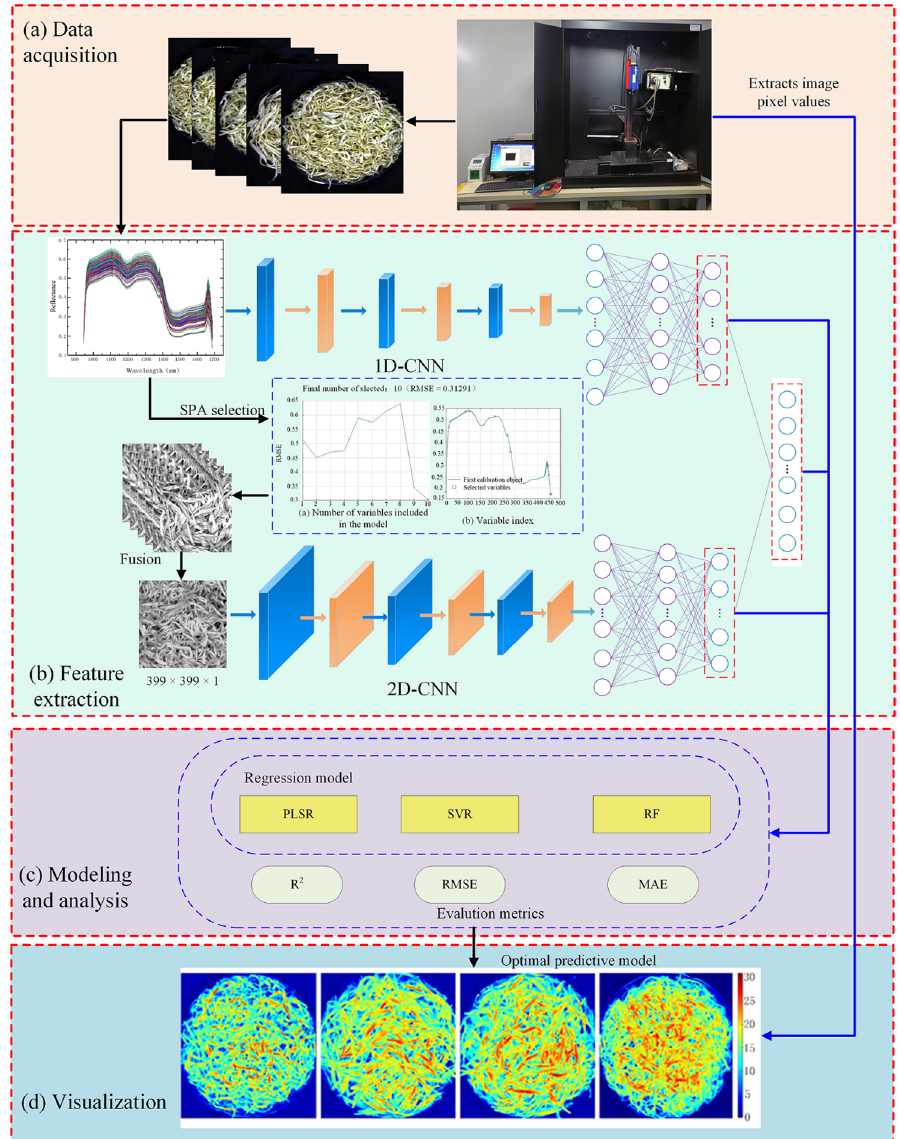
Figure 3. Technical flow chart of this study, including ( a ) data acquisition, ( b ) feature extraction, ( c ) modeling and analysis, and ( d ) visualization.